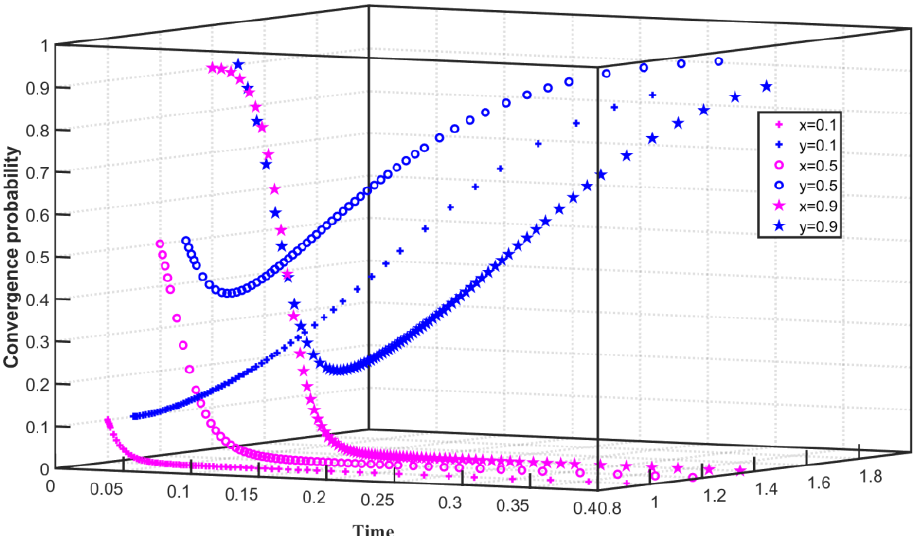
Figure 2. Evolution path of two-party game system under high emission reduction cost and high enterprise punishment.